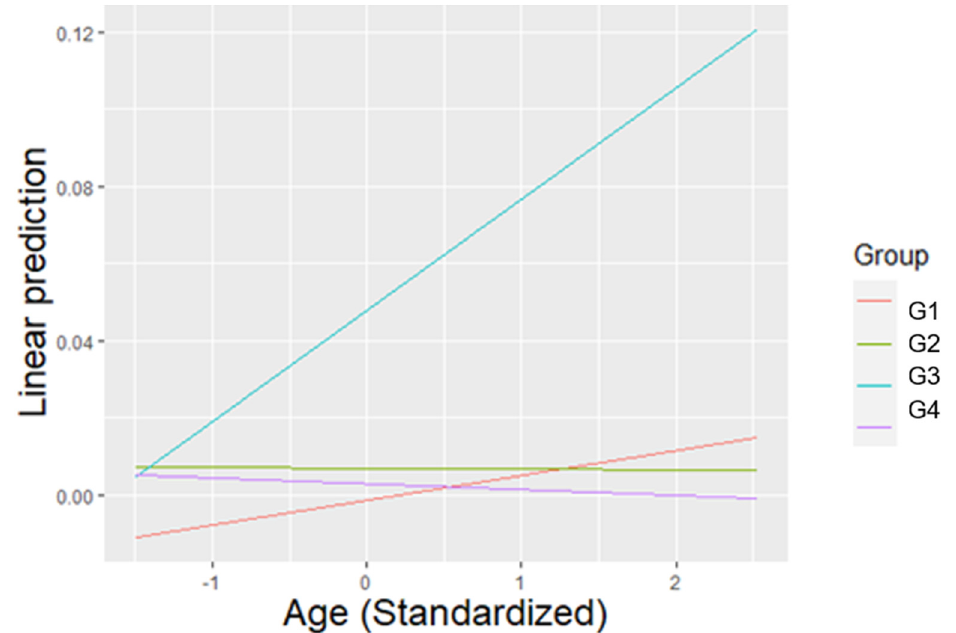
Figure 2. The linear prediction of the relative frequency of agonistic behaviours according to the average value of age (previously standardized), for each group. For the average value of age, Group 3 displayed significantly more agonistic behaviours than group 2. 3 displayed significantly more agonistic behaviours than group